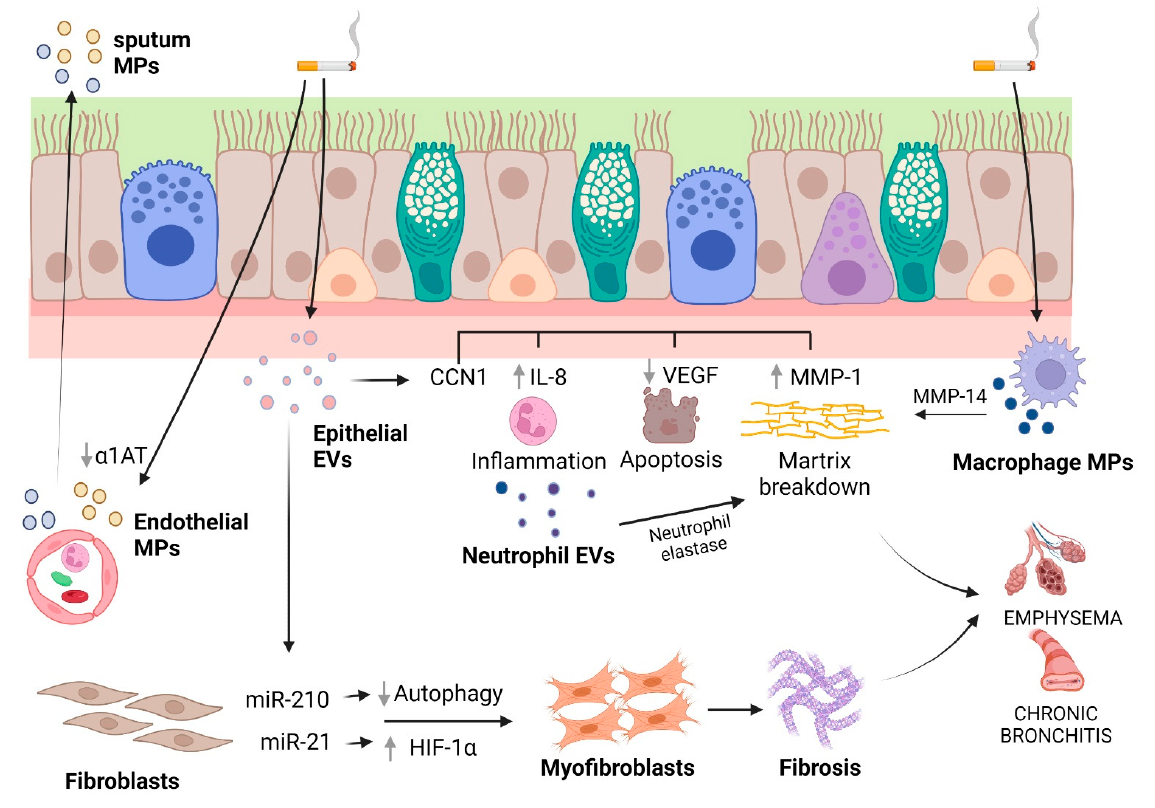
Figure 3. Involvement of EVs in COPD inflammatory lung disease and remodeling. Cigarette smoke induces EV release, which due to their miRNAs cargo cause reduced autophagy (miR210) or an increase in HIF-1a, both events leading to fibroblast differentiation in myofibroblasts and eventually lung fibrosis. Epithelial EVs induced by cigarette smoke are enriched with CCN1, which has various effects, such as IL-8 secretion (and neutrophil recruitment), decreased VEGF (and apoptosis), and increased MMP1 levels (and matrix breakdown). Matrix degradation is also due to macrophage MPs, whose release is triggered by smoke, and that are enriched with MMP-14. Endothelial-cell-derived MPs are enriched with α 1AT, which could be down-regulated by smoke. They have been found also in the sputum of CF patients, together with those derived by circulating granulocytes, platelets, and red blood cells. Created with Table 1. Pathogenic roles of EVs in CF and COPD.